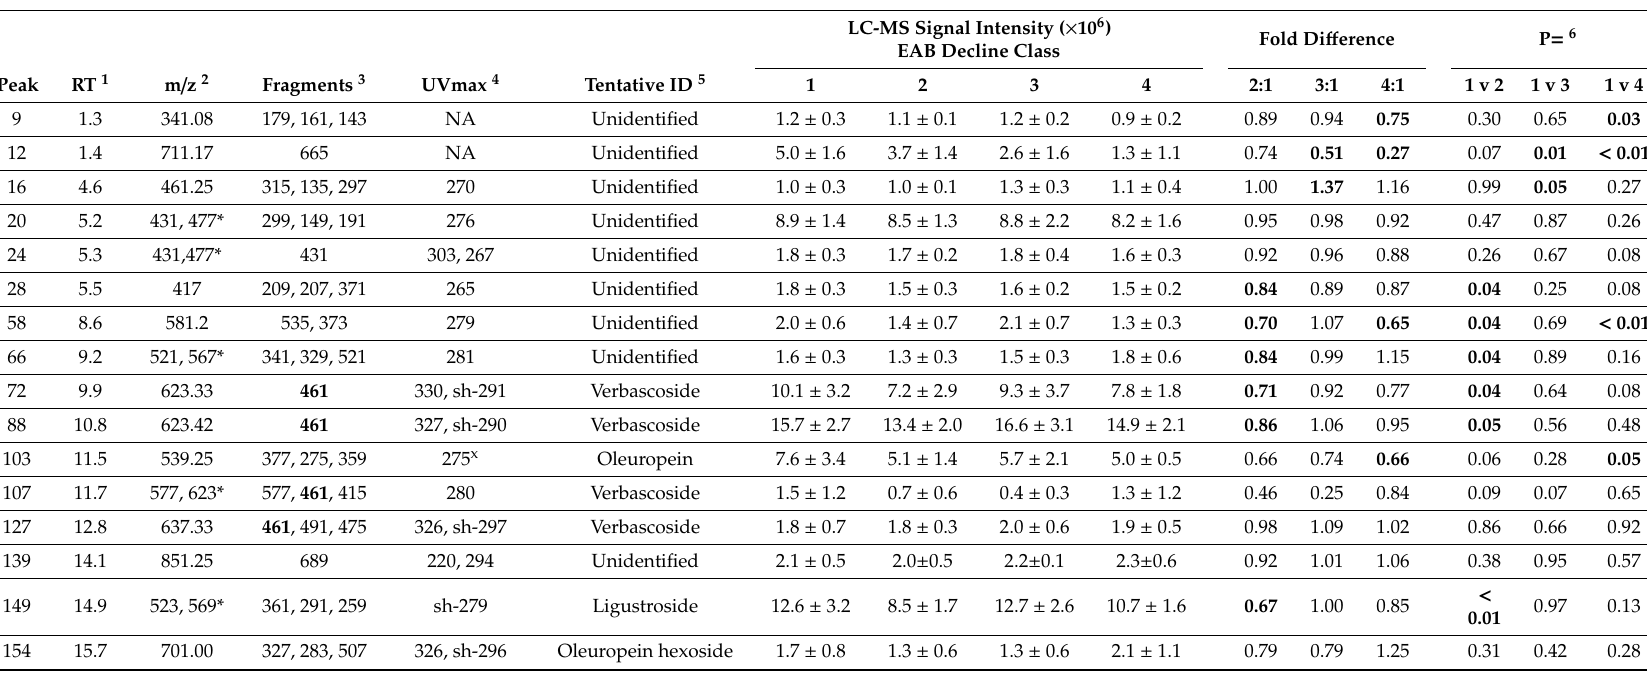
Table 7. Relative presence of the sixteen most abundant phenolic compounds detected in green ash bark of trees from di ff erent classes of